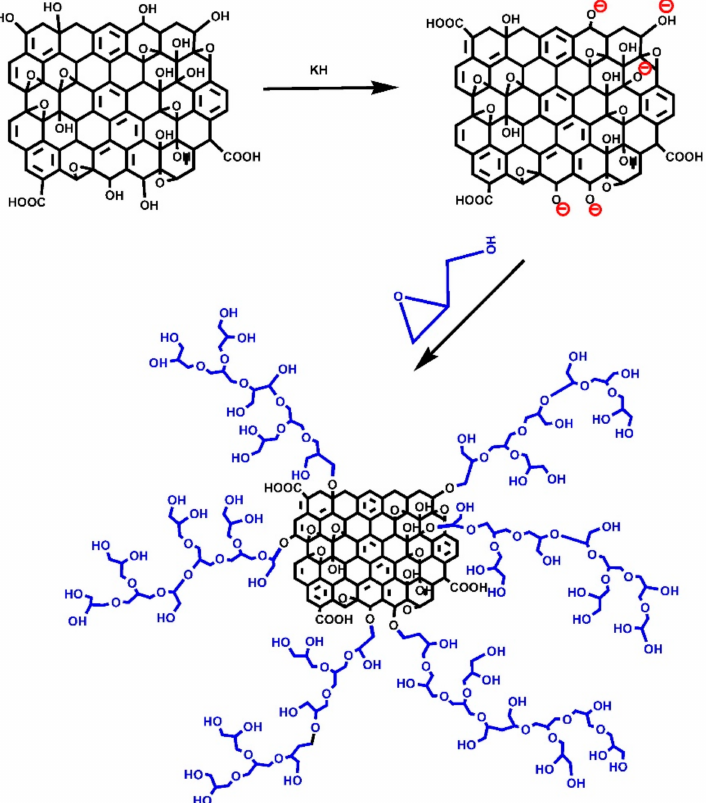
Figure 8. Schematic representation of the synthesis of HPG-GO hydrogel. Reprinted with premission from ref. [112]. Copyright 2021